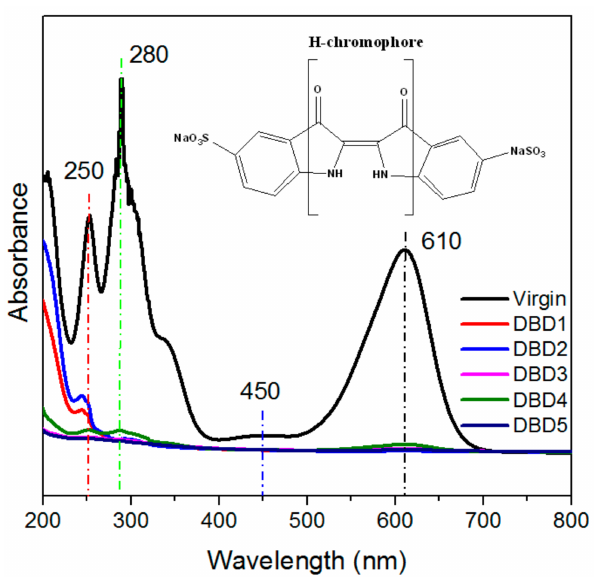
Figure 5. The UV-Vis spectra of virgin and DBD regeneration treatment